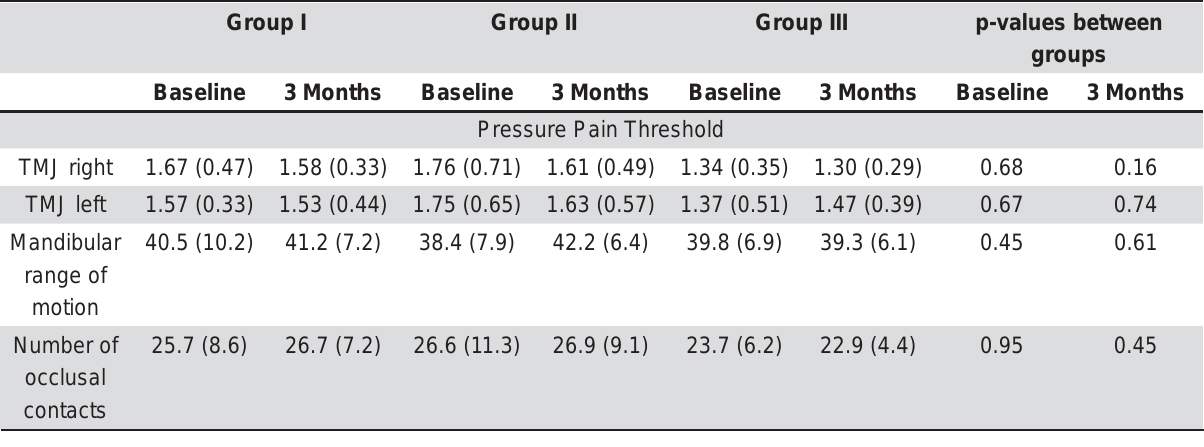
Table 1- The mean standard deviation Visual Analogue Scale (VAS) score, pressure pain threshold (kgf/cm 2 ) and mandibular range of motion (in millimeters) for all groups at baseline and 3 months (ANOVA and Tukey´s